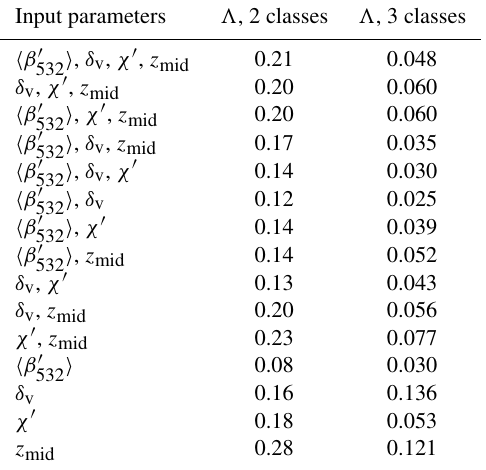
Table 5. Wilks’ lambda ( (cid:51) ) for two-class (center column) and three-class (right column) FKM classifications using different ob- servational dimensions (left